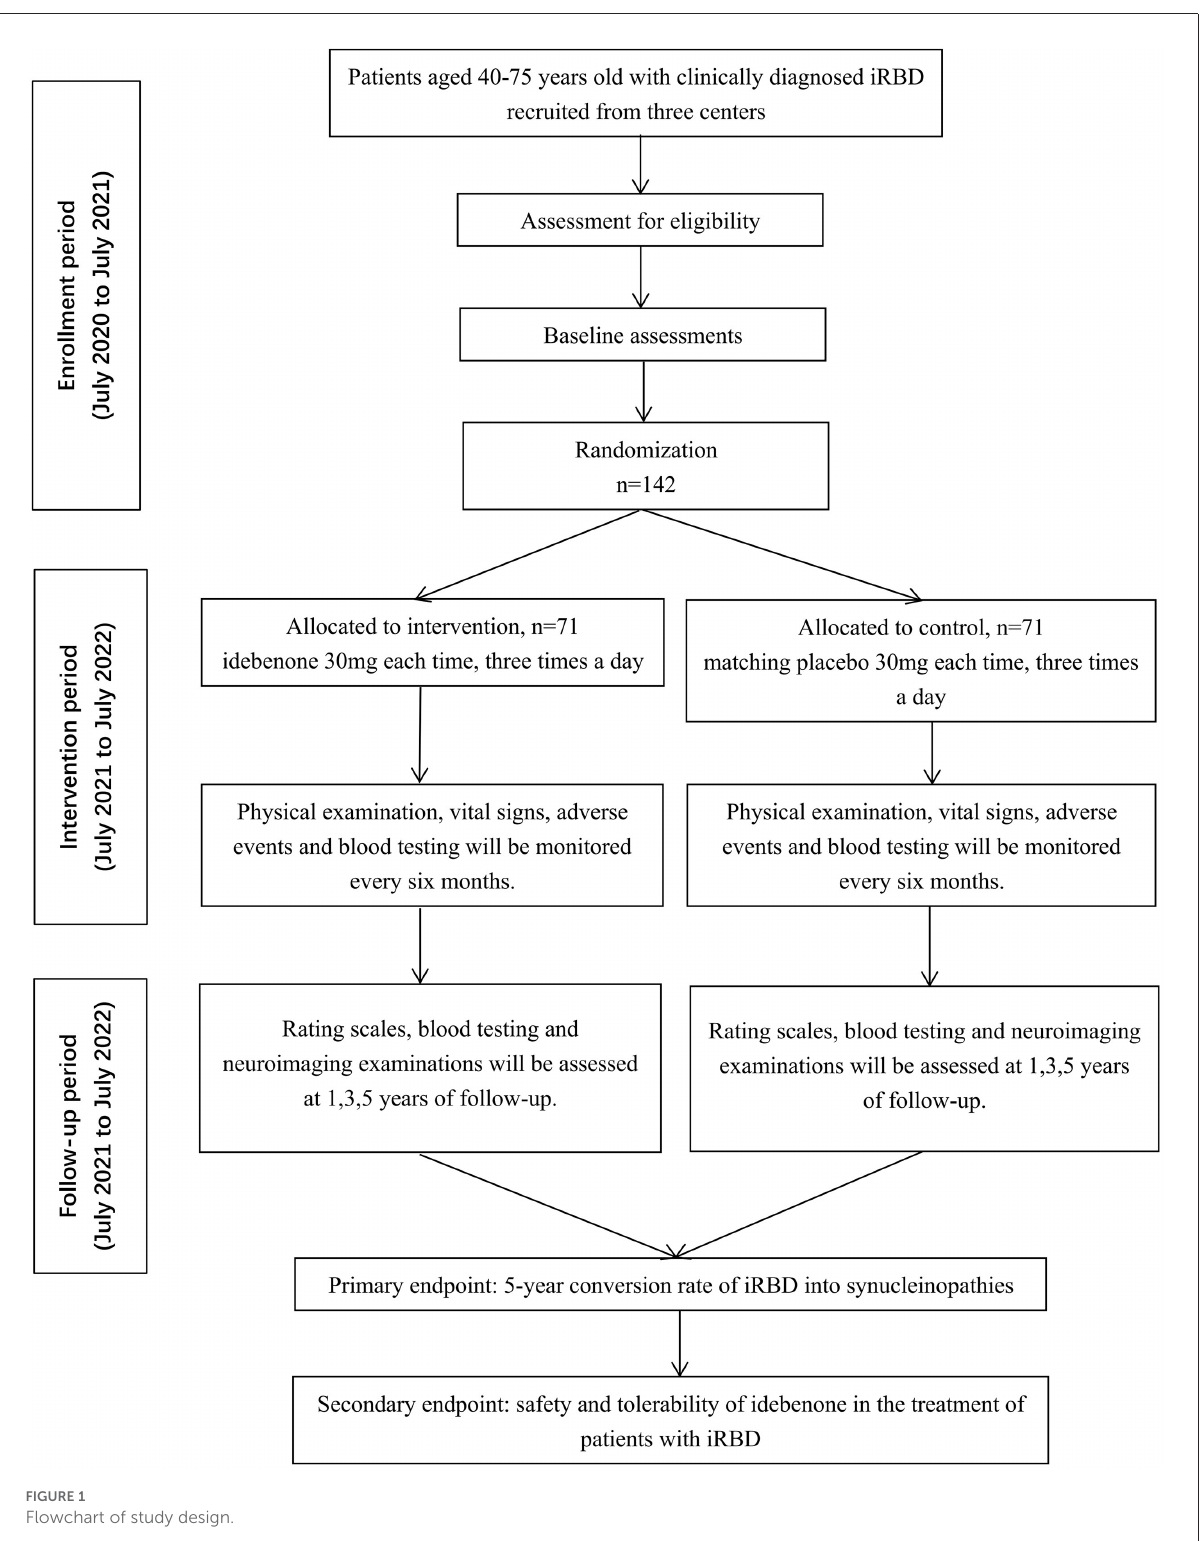
FIGURE1 Flowchart of study